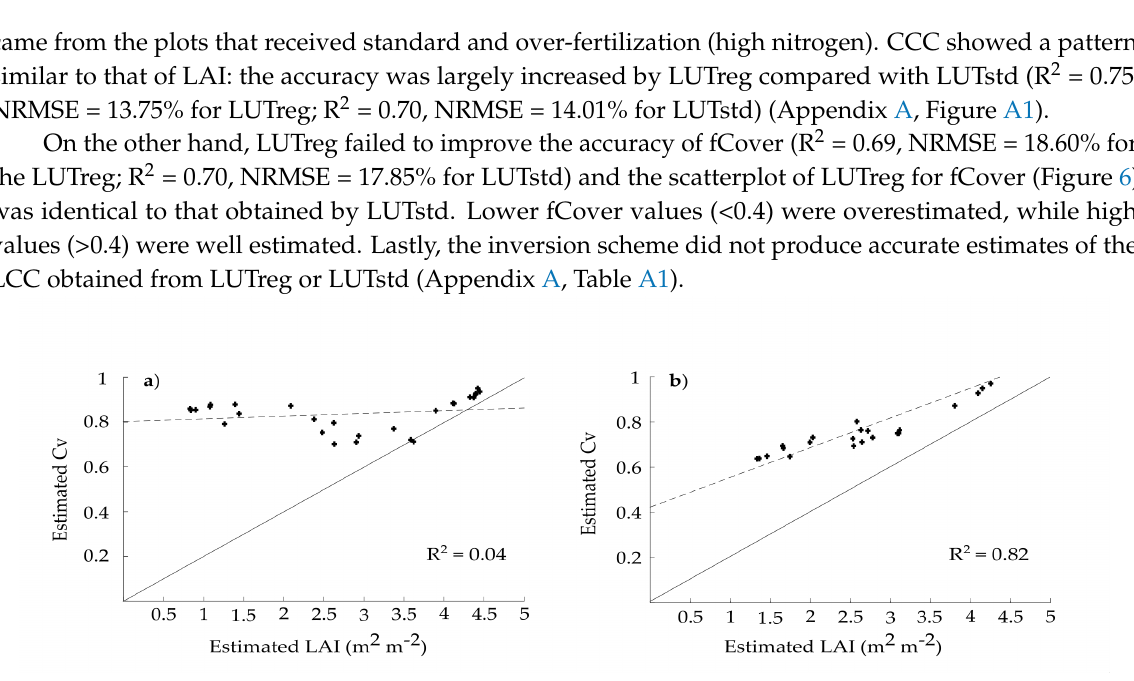
Figure 4. Relation between estimated LAI and Cv from LUTstd ( a ) and LUTreg ( b ).